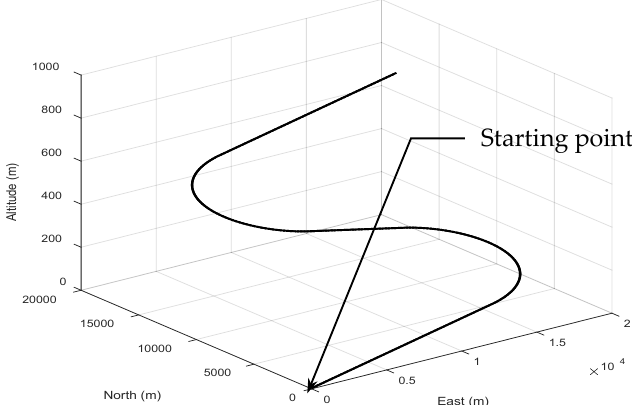
Figure 4. Test trajectory for the simulated vehicle.